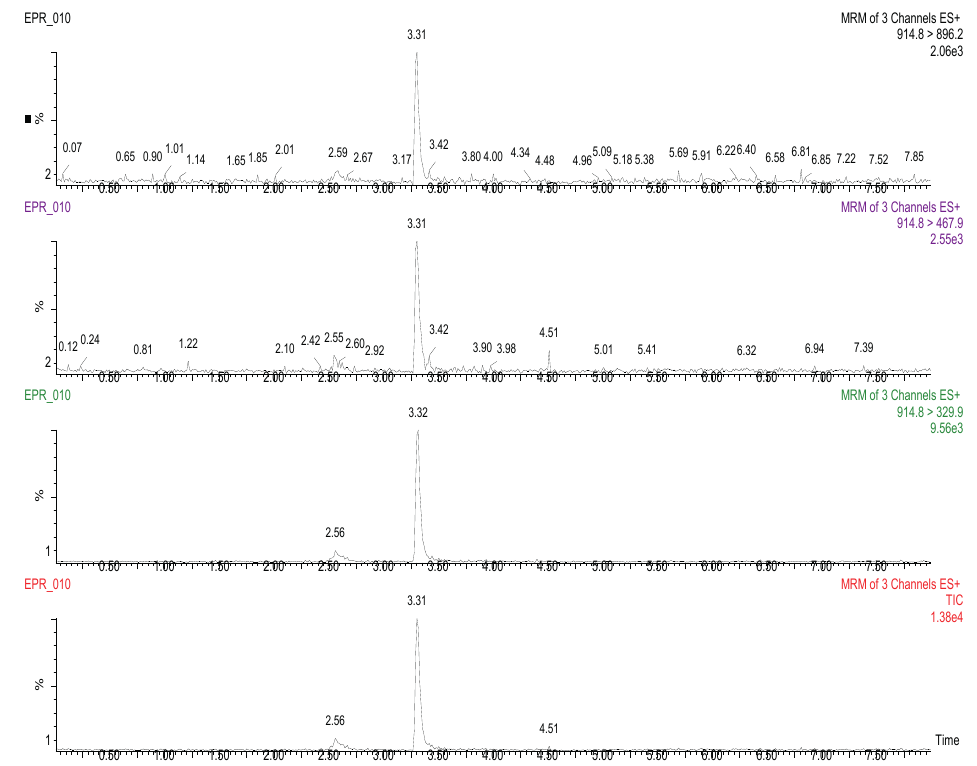
(in a muscle sample: 12.6 1a